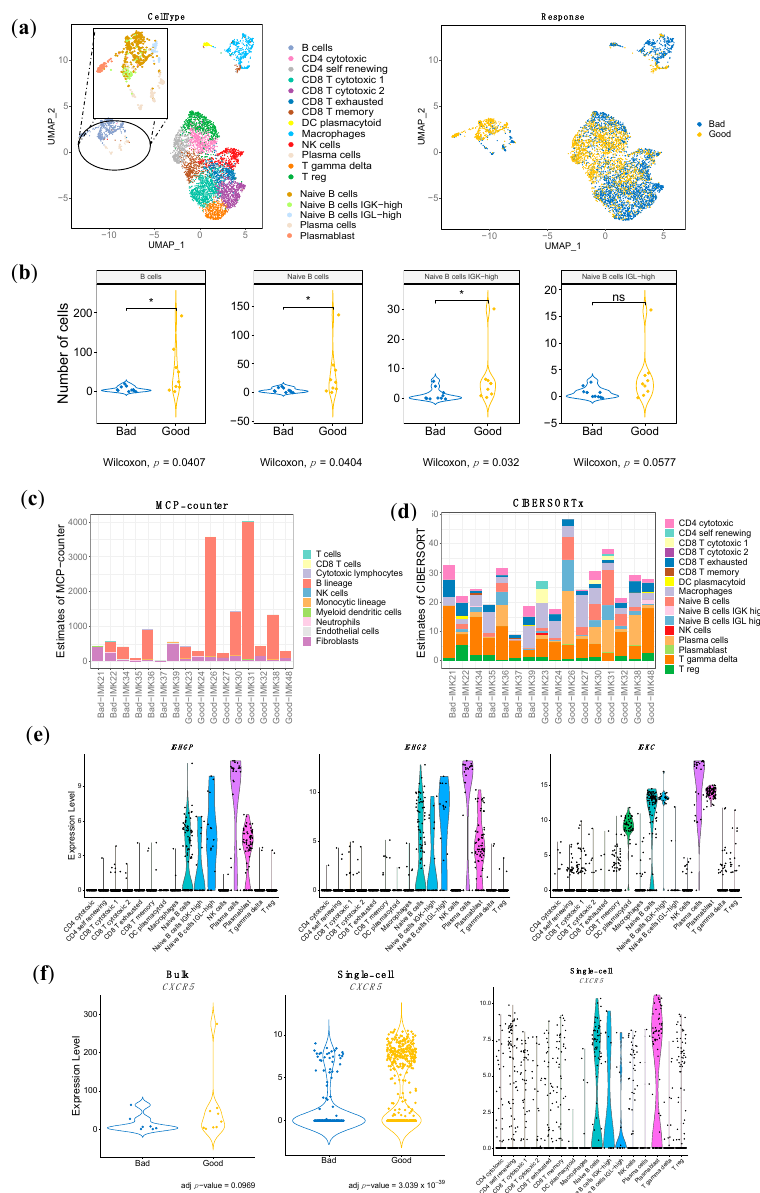
Figure 3. Distribution and enrichment according to response of the stromal immune cells of the single-cell RNA-seq validation cohort, estimation of the population abundance by bulk RNA-seq transcriptomic deconvolution and bulk RNA-seq gene signature mapping to single cell RNA-seq. ( a ) UMAP representation of the stromal cells, different types of immune cells. Each dot represents a single cell, and they are clustered and colored according to each cell type and according to the pattern of response. Increased resolution in B-cell lineage was performed to identify Naïve B cells, Naïve B cells IGK-high, Naïve B cells IGL-high, Plasma cells and Plasmablasts. ( b ) Comparison of the abundance among good and bad responders in B cells and the refined B-cell clusters. ( c ) and ( d ) Estimation of cell-population abundance using gene expression profile based on gene markers ( c ) (MCP-counter) and based on a custom signature matrix based on scRNA-seq analysis ( d ) (CIBER- SORTx). ( e ) Violin plot of the gene expression in the scRNA-seq of three representative genes from our gene signature stratified by cell type validated in the scRNA-seq analysis. ( f ) Validation of the presence of the gene CXCR5 , which is associated with tertiary lymphoid structures, in both bulk RNA-seq and scRNA-seq. CXCR5 expression distribution over cell types in scRNA-seq. In ( b ) p -value < 0.05 is shown as *; ns refers to